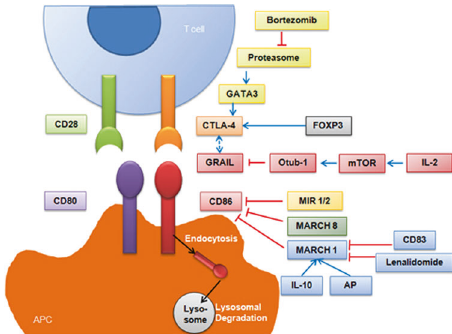
Fig. 3 Schematic diagram of the regulation of CTLA4/B7 pathway by modulating